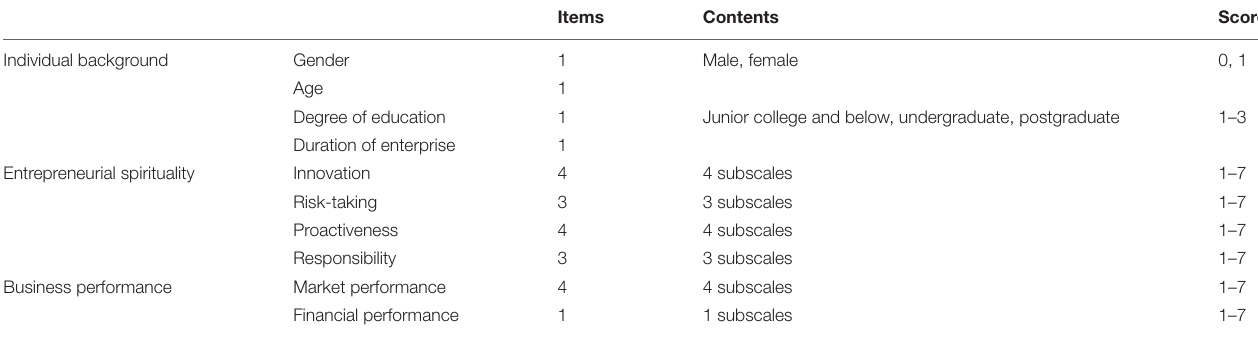
TABLE 1 | The structure of the questionnaire.